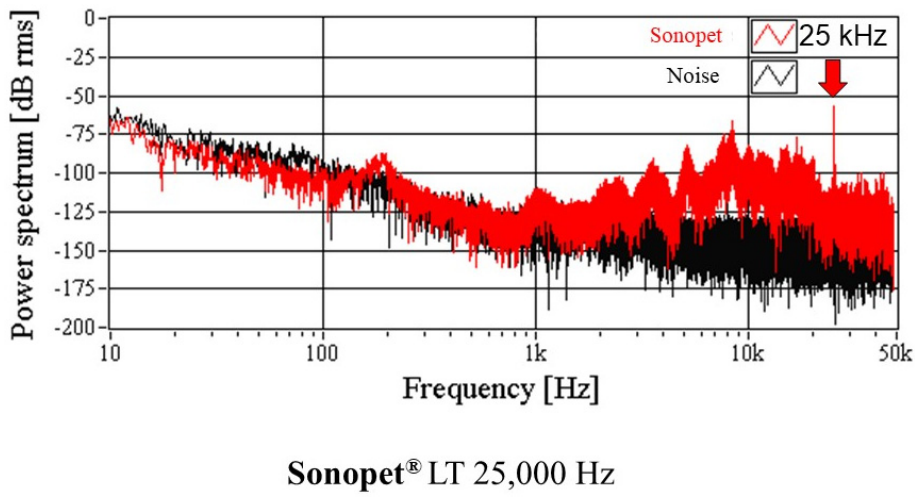
Figure 11. Comparison of the power spectrum produced by the Sonopet ® at 25 kHz in LT mode versus background noise.